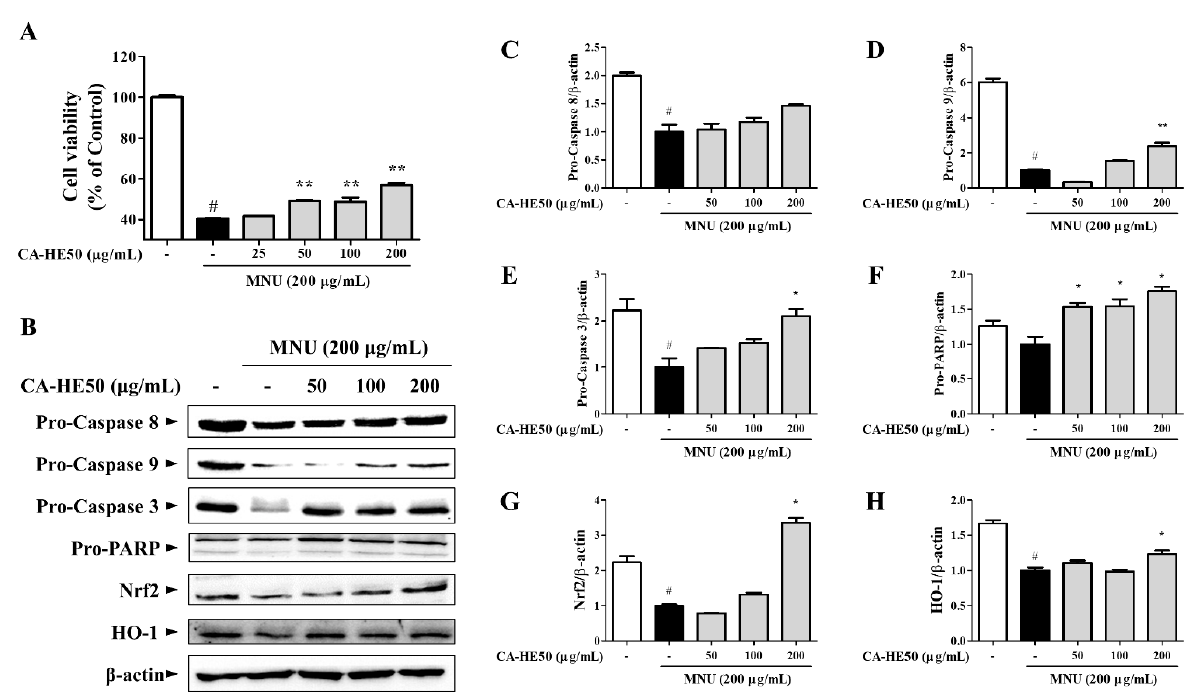
Figure 3. Antiapoptotic efficacy of CA-HE50 through the activated Nrf2/HO-1 antioxidant signaling pathway. ( A ) Cy- toprotective effect of CA-HE50 against MNU. ( B ) Western blot analysis for expression of proteins associated with retinal damage with MNU. CA-HE50 efficacy results on: ( C ) pro-caspase-8 protein expression; ( D ) pro-caspase-9 protein expression; ( E ) pro-caspase-3 protein expression; ( F ) pro-PARP protein expression; ( G ) Nrf2 protein expression; and ( H ) HO-1 protein expression. # p < 0.05 vs. normal control group. * p < 0.05 and ** p < 0.01 vs. MNU-treated group. Abbreviations: MNU, N -methyl- N -nitrosourea; PARP, poly (ADP-ribose) polymerase; Nrf2, nuclear factor erythroid 2; HO-1, heme oxy- genase-1.